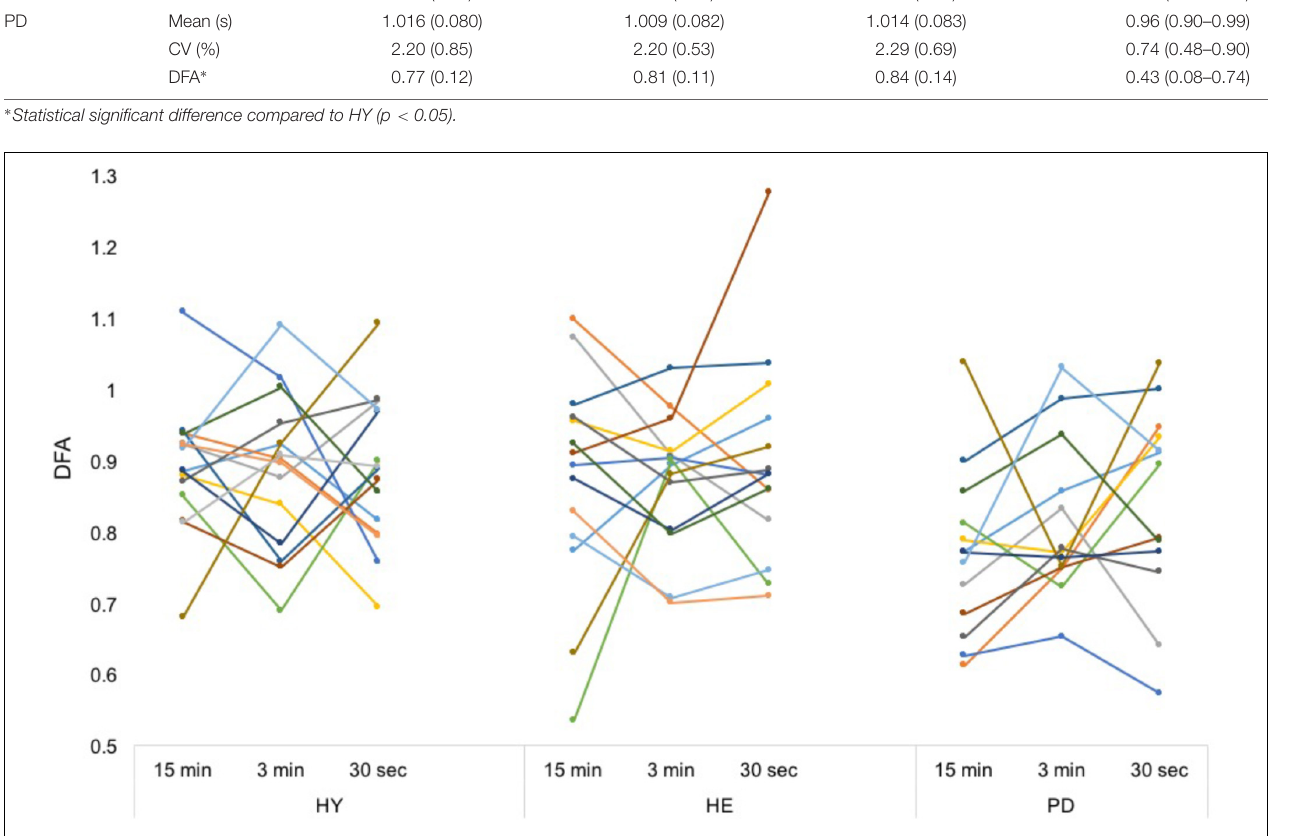
FIGURE 3 | Individual DFA values. Each color represents a participant. From a simple visual inspection, it is apparent that while mean values are similar, each participant’s DFA values differ a lot between conditions, without any consistent trend. Intra-class correlation coefficients can be found in Table 2